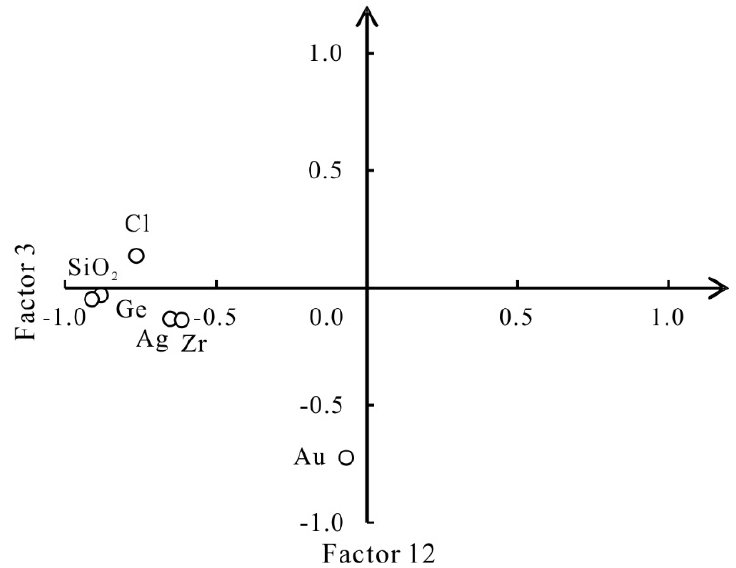
Figure 9. Biplot of Factor 3 (SiO 2 − Ge − Cl − Ag − Zr association) vs. Factor 12 (Au). Circles indicate elements.